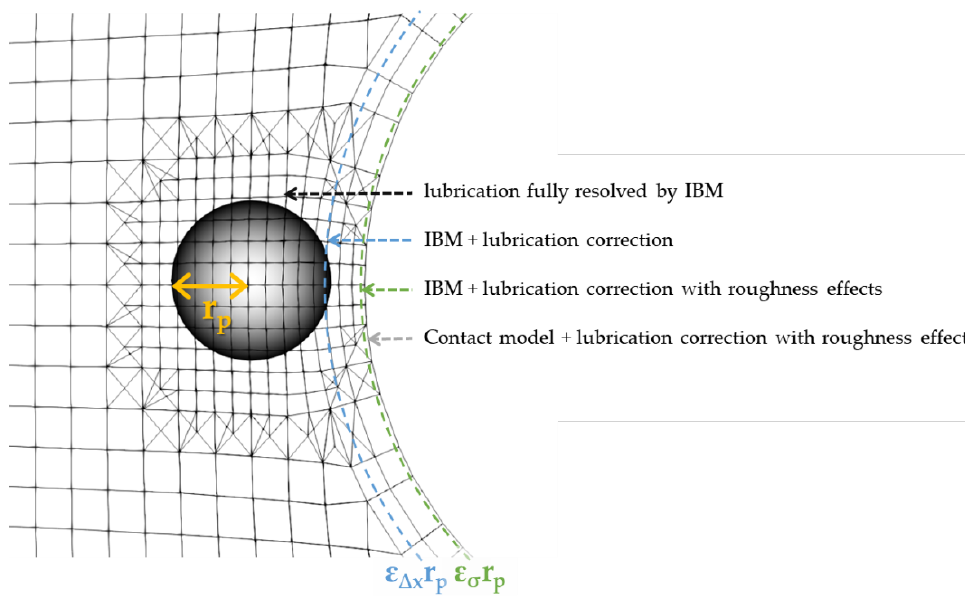
Figure 2. Schematic illustration (based on [49]) of the combination of the IBM, lubrication correction and contact model for solid–solid interactions.